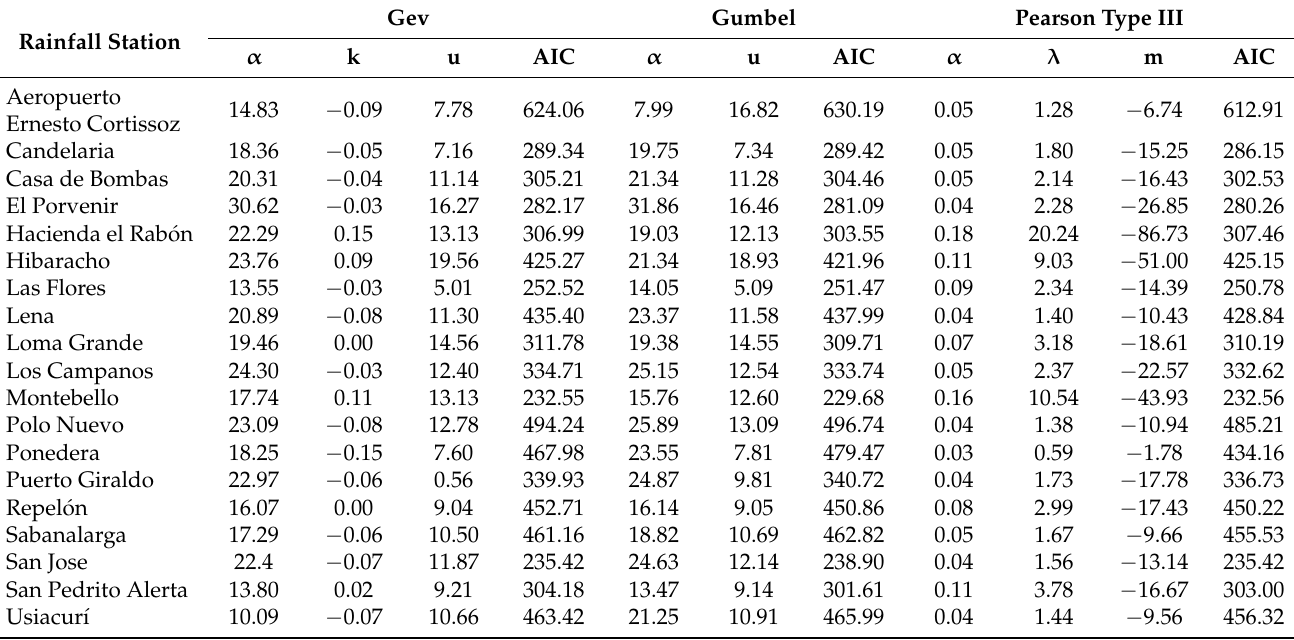
Table A4. Summary of parameters and AIC values of the different distribution functions using the method of moments fit.